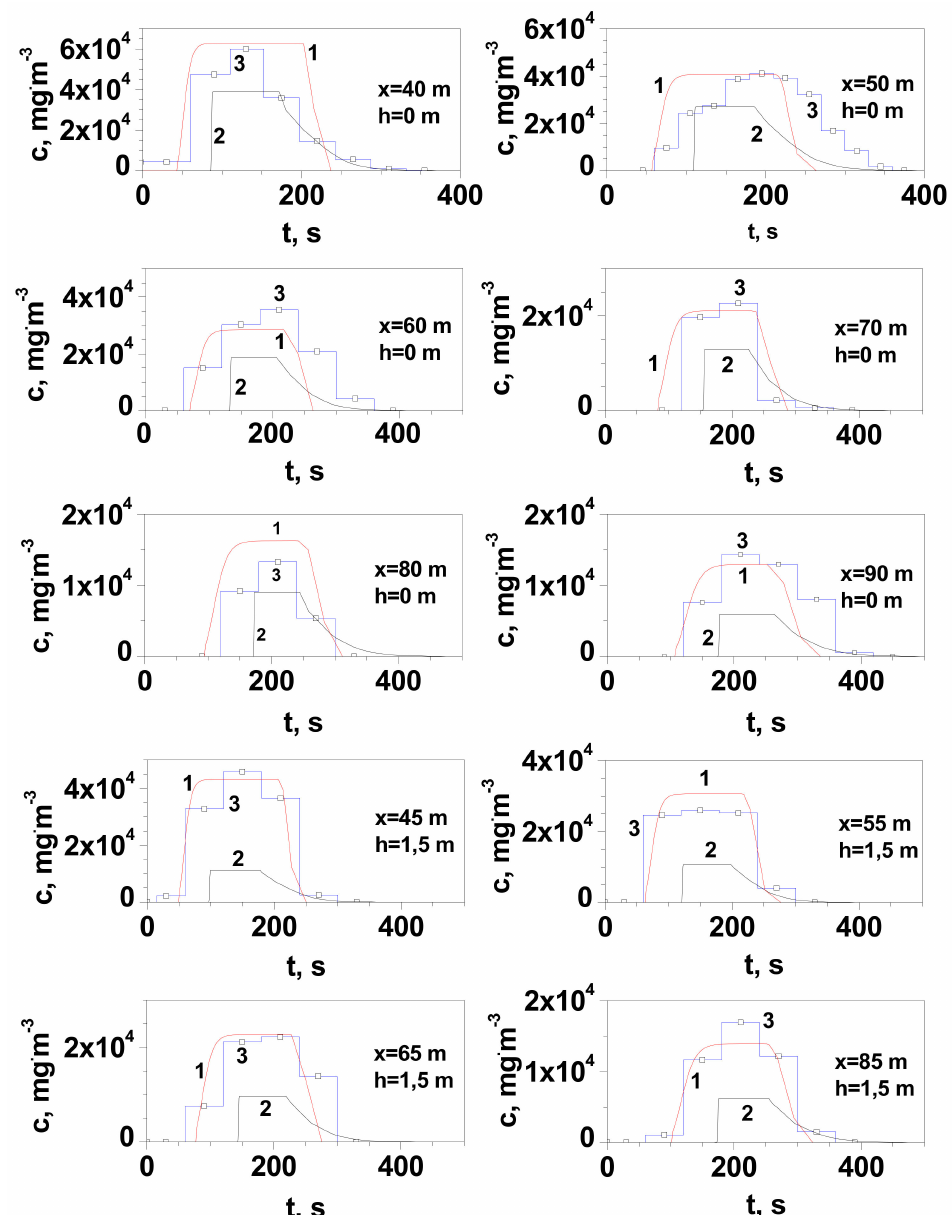
Figure 6. Comparison of the concentration dependence as a function of time for the Gaussian gas model ( 1 ) and the dense gas model ( 2 ) against the obtained experimental data ( 3 ) at height (h) and at distance (x) from the release location in the wind blowing direction. Atmospheric conditions of the measurement series 3: T = 20.3 ◦ C, v = 0.67 m/s, RH = 44%, p = 1002.7 hPa. Release parameters: Q = 1.7 kg/s, p out = 5.9 atm, t = 163 s, h = 0.75